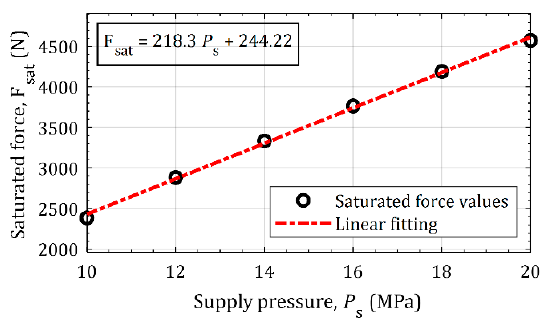
Figure 6. Linear fit of saturated force values as a function of the supply pressure.